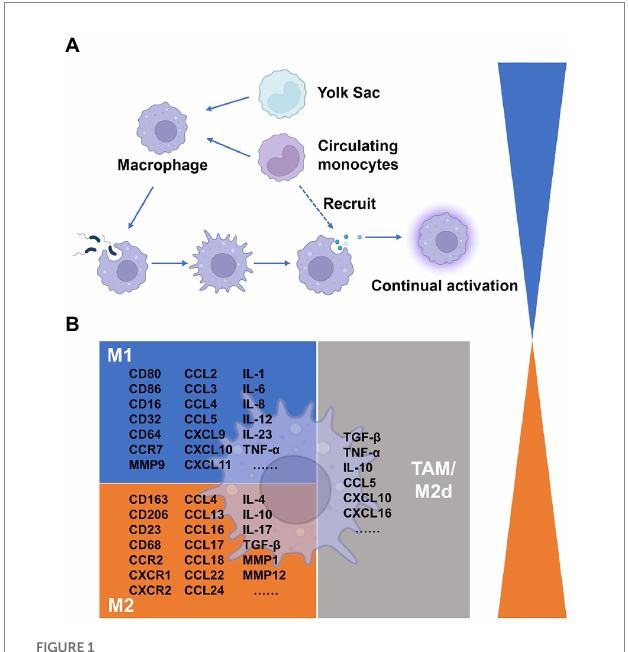
FIGURE 1 Summary of macrophages in the tumor microenvironment. (A) Origins of Macrophages. (B) Cytokines associated with macrophage differentiation to the classically and alternatively activated